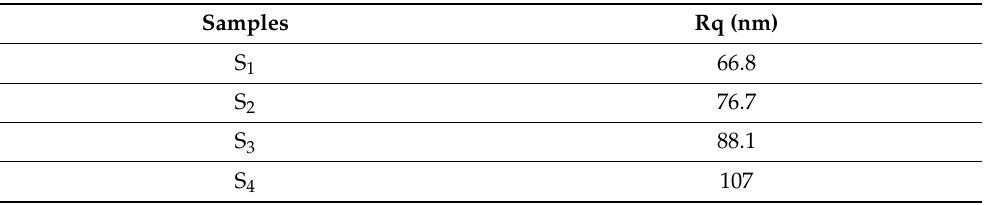
Table 2. Surface roughness for the synthesis of nanocomposites on PTFE substrates (S 1 ) 1:7, (S 2 ) 1:3, (S 3 ) 3:5, and (S 4 )